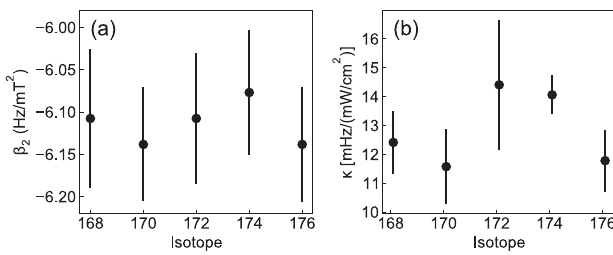
FIG. 5. Systematic effects of (a) quadratic Zeeman shift and (b) probe light shift. Error bars show fitting errors with 1 σ confidence